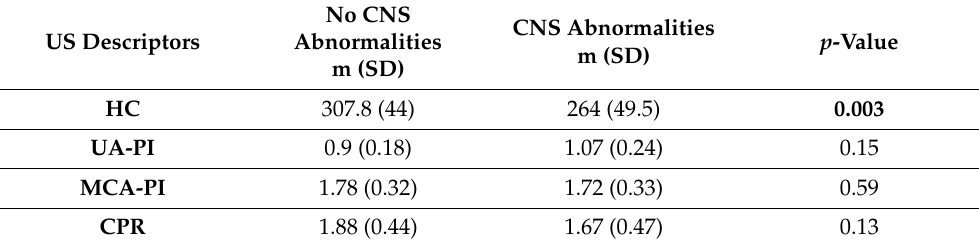
Table 4. Correlations among US descriptors and the presence of brain injury at MRI, using mean (m) and standard deviation (SD). US: ultrasound; MRI: magnetic resonance imaging; CNS: central nervous system; HC: head circumference; UA-PI: pulsatility index of umbilical artery; MCA-PI: pulsatility index of middle cerebral artery; CPR: cerebroplacental